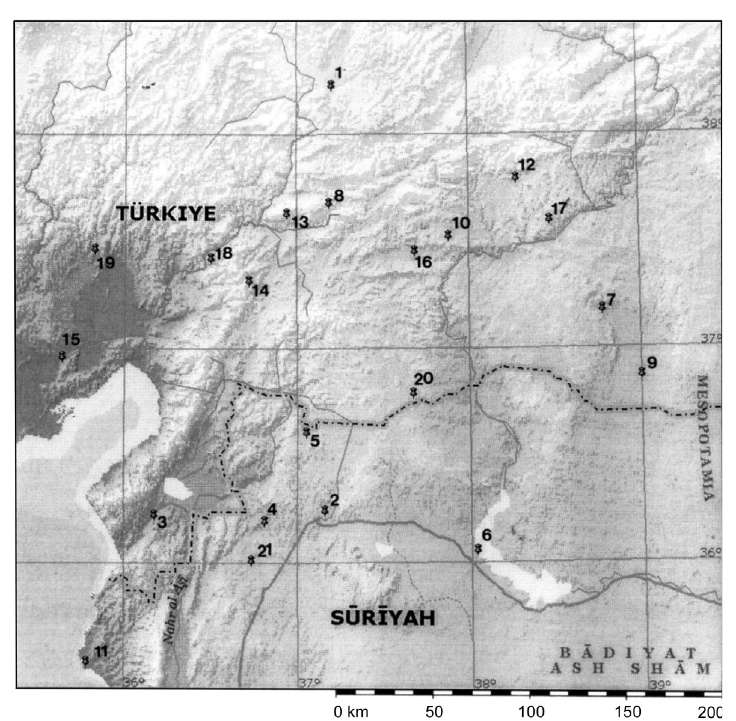
Fig. 2. Location map of the earthquake of 1114. 1 – Ablastha; 2 – Aleppo; 3 – Antioch; 4 – Atharib; 5 – Azaz; 6 – Balis; 7 – Edessa; 8 – Hiesuvank; 9 – Harran; 10 – Kaysun; 11 – Latakiya; 12 – Mansur; 13 – Maras; 14 –